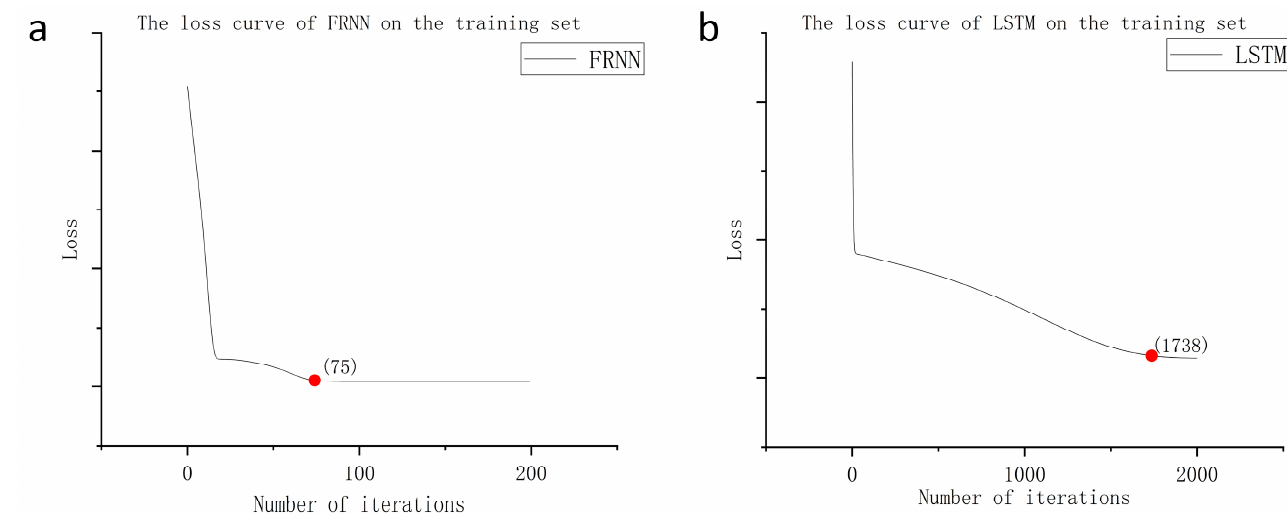
Figure 23. Comparison of loss function curves of FRNN and LSTM.